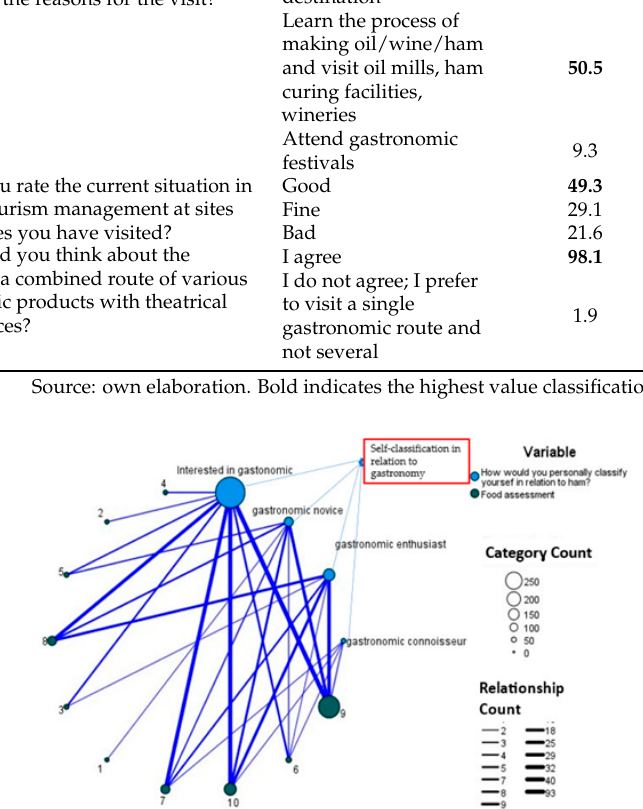
50 years) main motivation was tasting dishes that feature olive oil, wine or Iberian